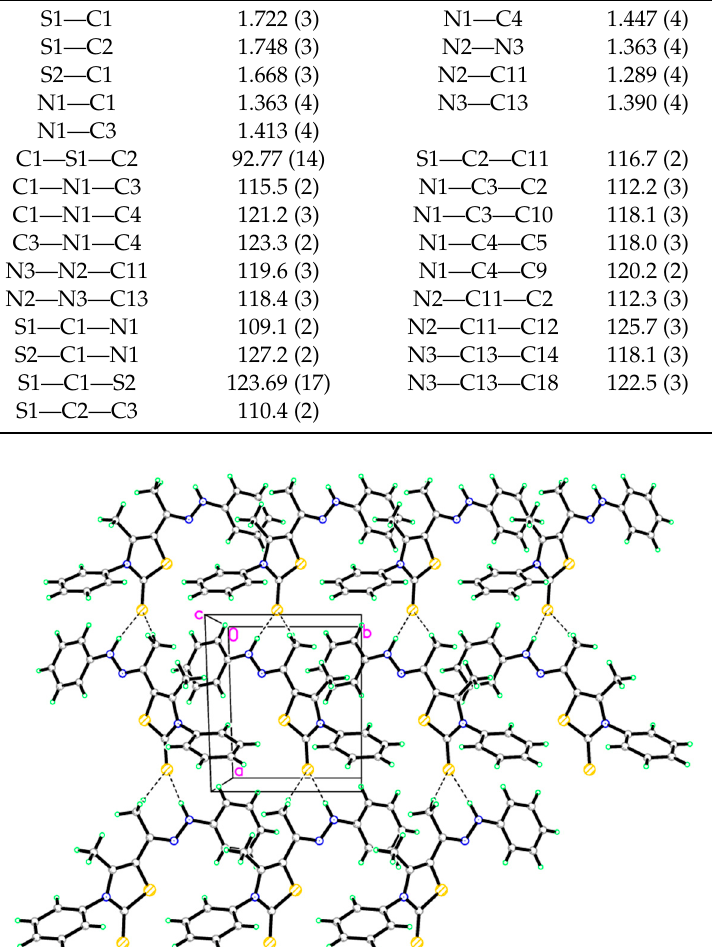
Figure 1. ORTEP diagram of the thiazoline 5c . Displacement ellipsoids are plotted at the 40% probability level for non-H atoms.